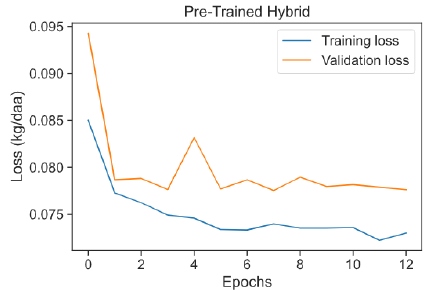
Figure 13. Training and validation loss for the pre-trained hybrid